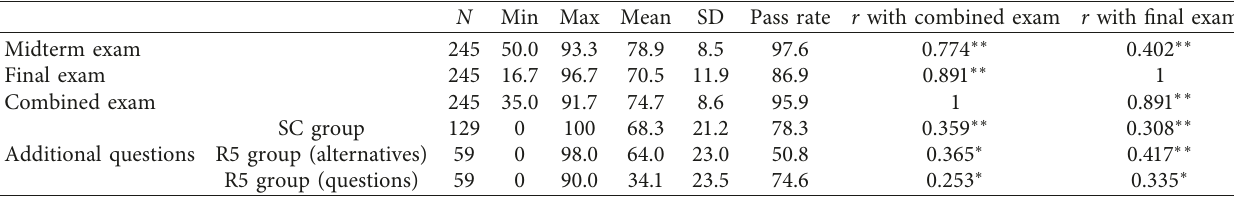
Table 3: Summary of performance in the 2012 regular exams and additional questions. The values given (except N and the correlations) are the respective percentage of the maximum possible